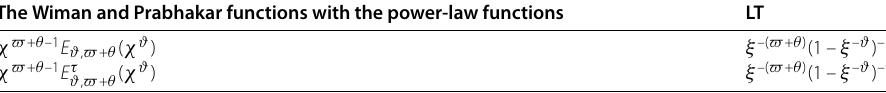
Table 1 The LT of the new extensions of Wiman and Prabhakar functions with the power-law functions